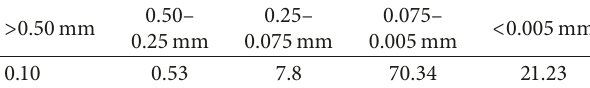
Table 1: Grain size composition of saline silty clay (unit: